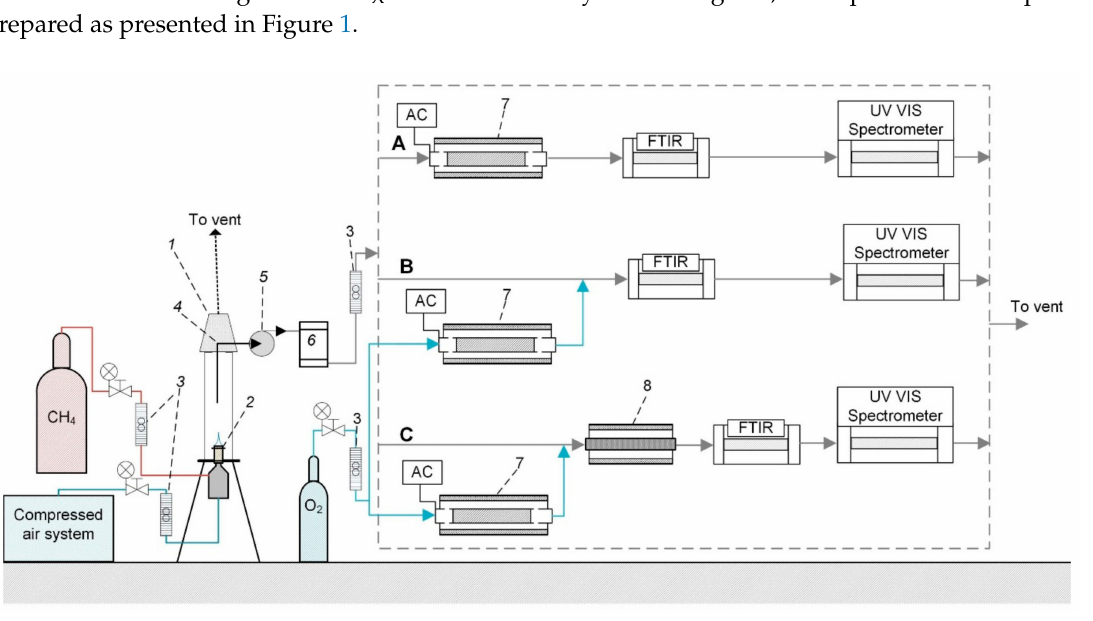
Figure 1. A scheme of combustion and NO X removal system: 1—a combustion chamber; 2—a gas burner; 3—a rotameter; 4—a probe for collecting the flue gas; 5—a rotary vane pump; 6—a condensation unit; 7—a dielectric barrier discharge device; 8—TiO catalyst.